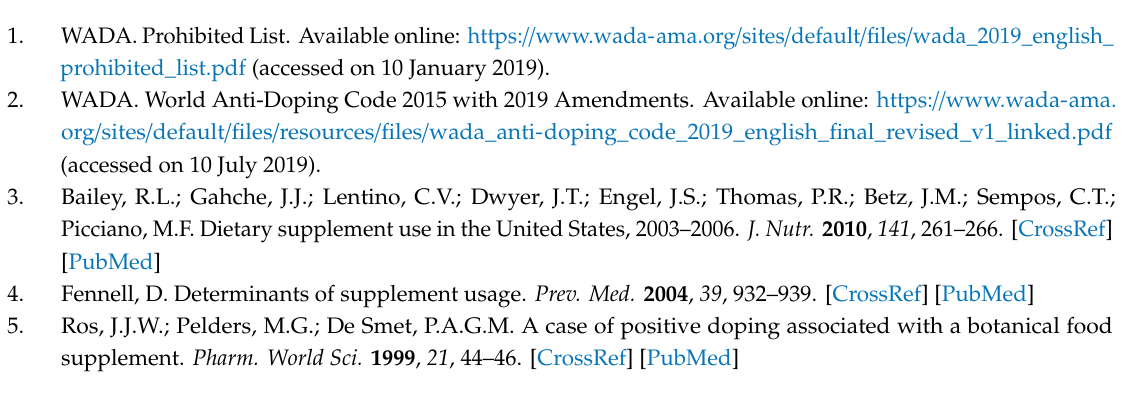
Table S1: Validation of liquid chromatography with tandem mass spectrometry for higenamine; Table S2: Analysis of variance (ANOVA) statistics of the quadratic model for the extraction yields of the alkaloids; Table S3: Intra- and inter-day precision and accuracy of the HPLC method for the determination of higenamine, liensinine, dauricine, isoliensinine, neferine, and nuciferine. Figure S1: Response surface plot and contour plot of the interaction e ff ects of extraction time, microwave power, and temperature on the yield of higenamine; Figure S2: Response surface plot and contour plot of the interaction e ff ects of extraction time, microwave power, and temperature on the yield of liensinine; Figure S3: Response surface plot and contour plot of the interaction e ff ects of extraction time, microwave power, and temperature on the yield of dauricine; Figure S4: Response surface plot and contour plot of the interaction e ff ects of extraction time, microwave power, and temperature on the yield of isoliensinine; Figure S5: Response surface plot and contour plot of the interaction e ff ects of extraction time, microwave power, and temperature on the yield of